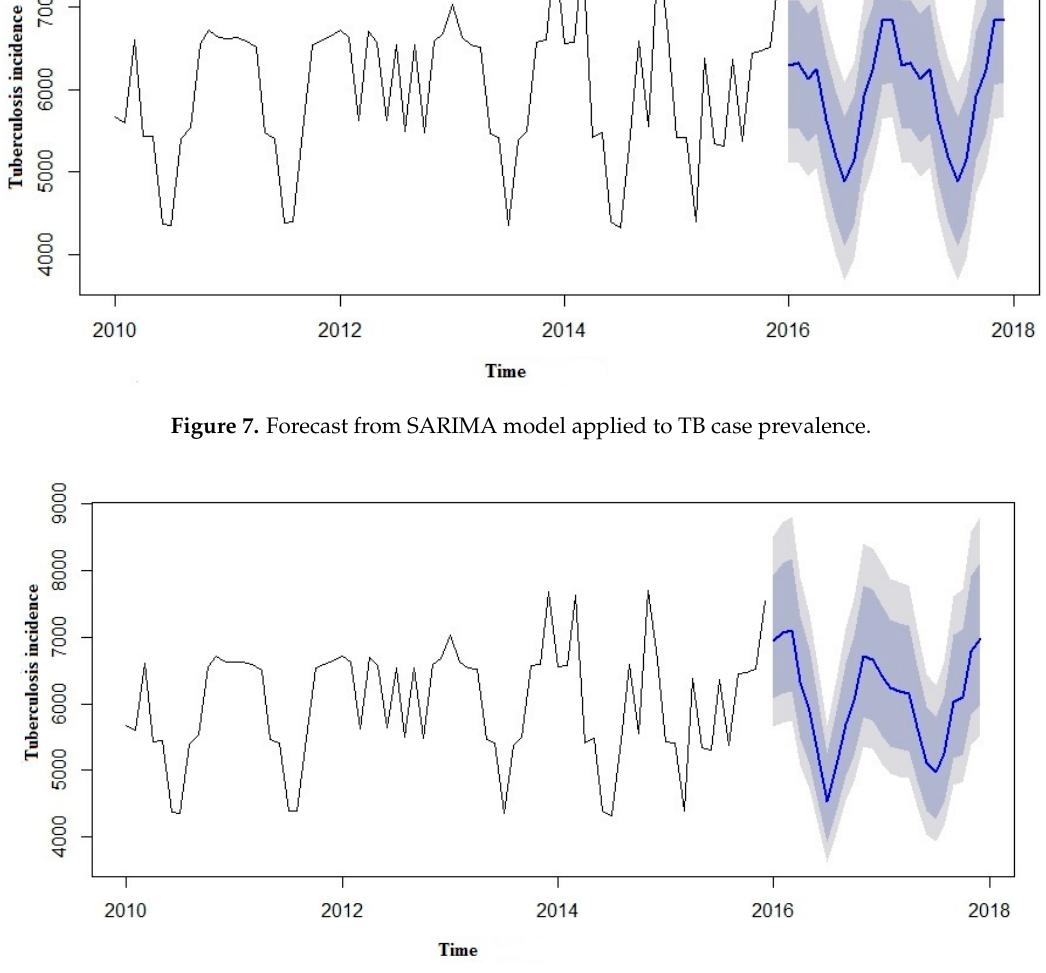
Figure 8. Forecast from SARIMA-NNAR model applied to TB case